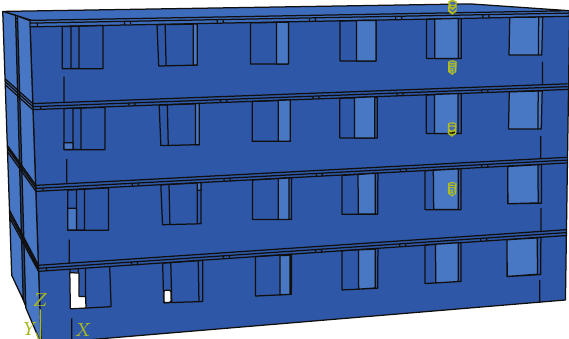
Figure 6: Model 4 without structural columns (1.2 m).